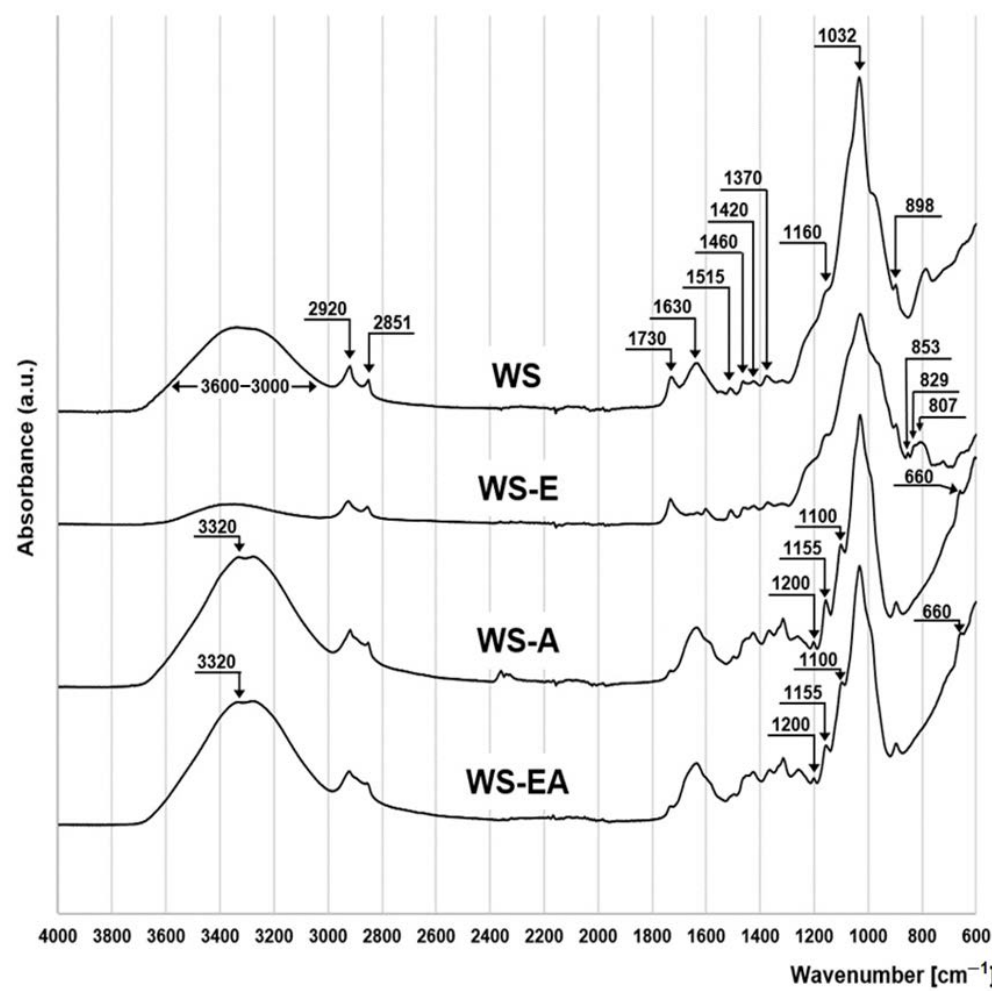
Figure 2. FTIR spectra for: WS, WS-E, WS-A, and WS-EA.